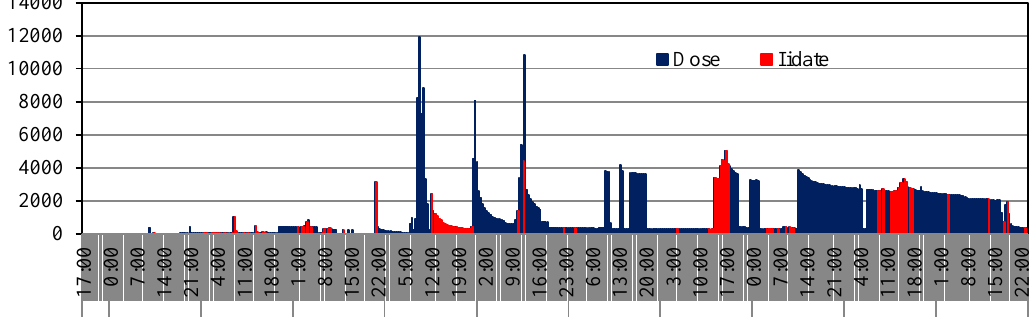
Figure 6. A time series of spatial dose (unit: μ Sv/h) and the ratio of pollution for Iidate village.